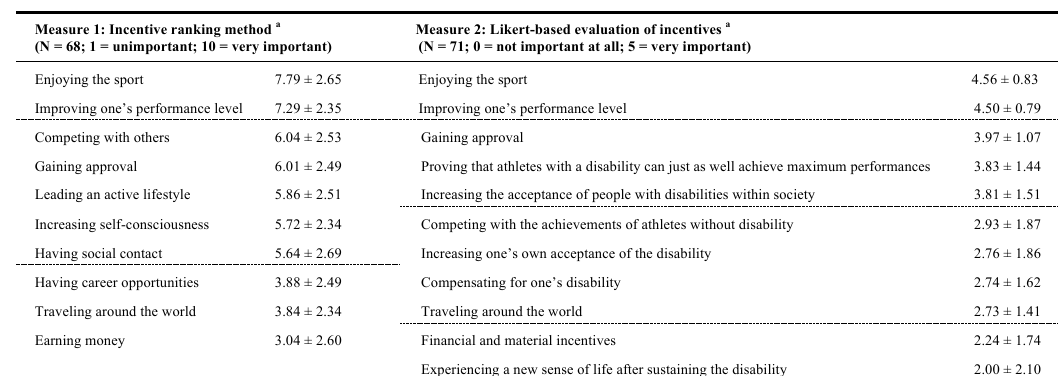
Table 3. Personal factors and situational incentives in the course of a career (M ± S) and multi- and univariate results of group differences between athletes with and without a disability in the mastery phase (controlled for gender and age)